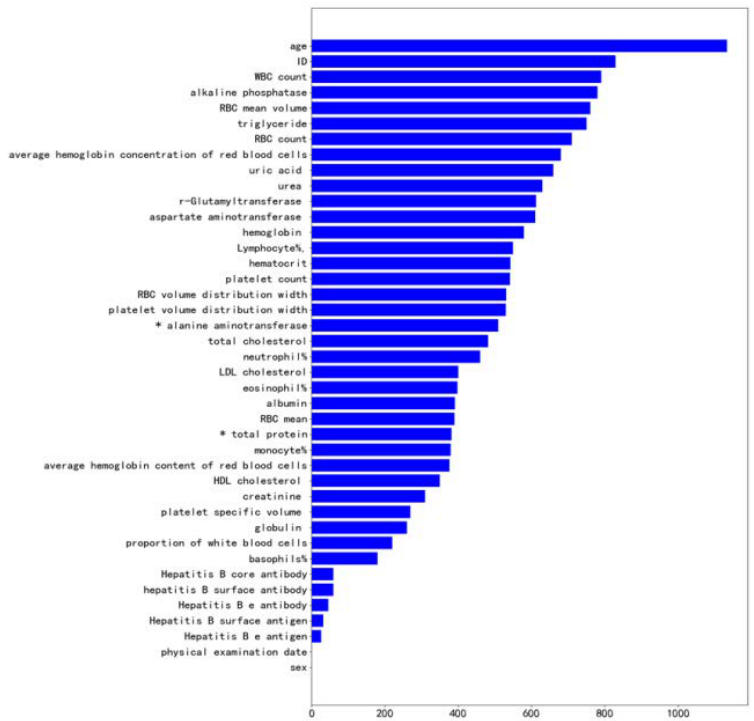
Figure 7. Eigenvalue influence weight graph.